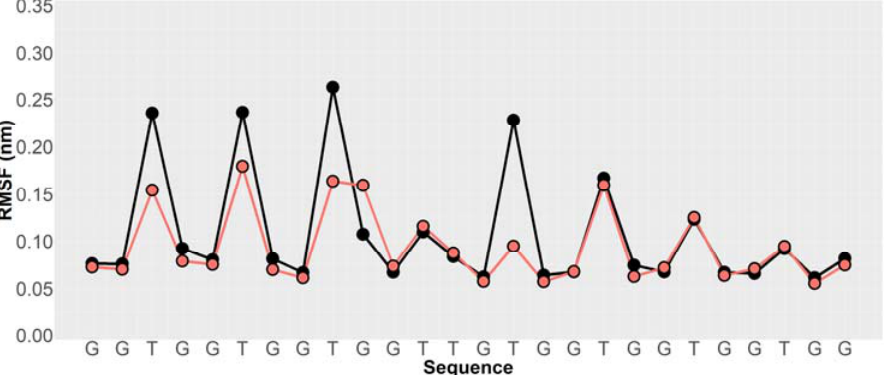
Figure 6. RMSF values calculated for the C2 ′ atoms of the AS1411 aptamer. Black and red filled circles indicate the values calculated for the free and cage-linked aptamers, respectively.